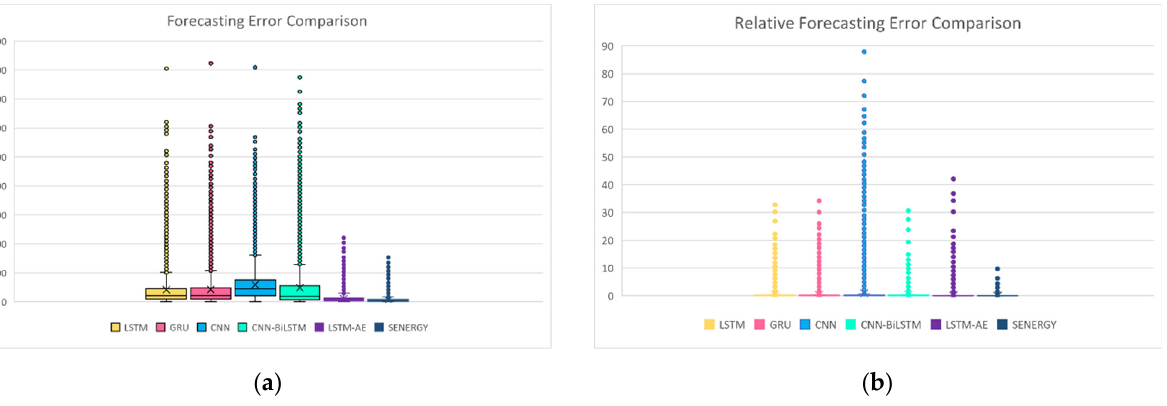
Figure 48. Comparison of SENERGY to other models based on ( a ) forecasting error; ( b ) relative forecasting error.